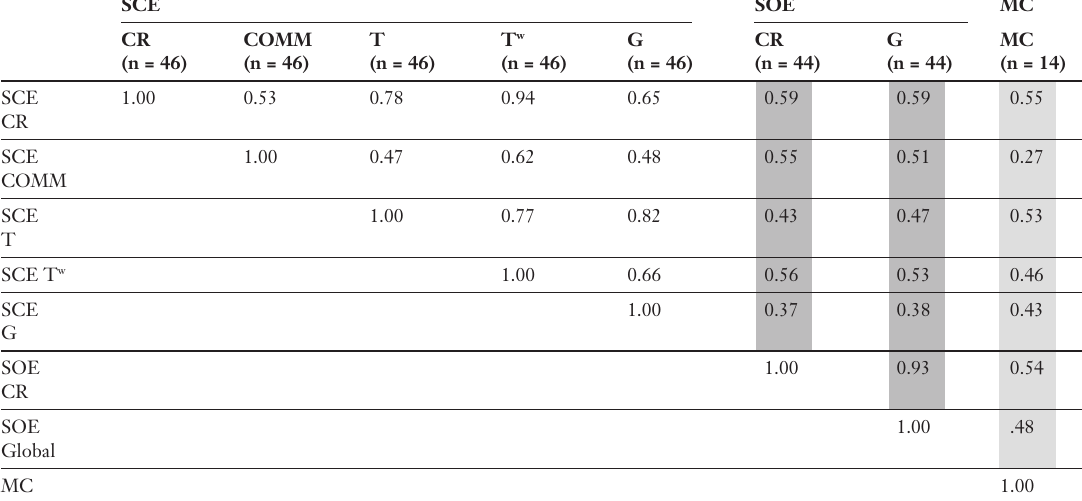
Correlations between Standardised Clinical Examination (SCE) CR, COMM, T, T w and G scores, the Struc- tured Oral Examina- tion (SOE) CR and G scores, and the Swiss Federal Part II Final multiple-choice (MC) written examination